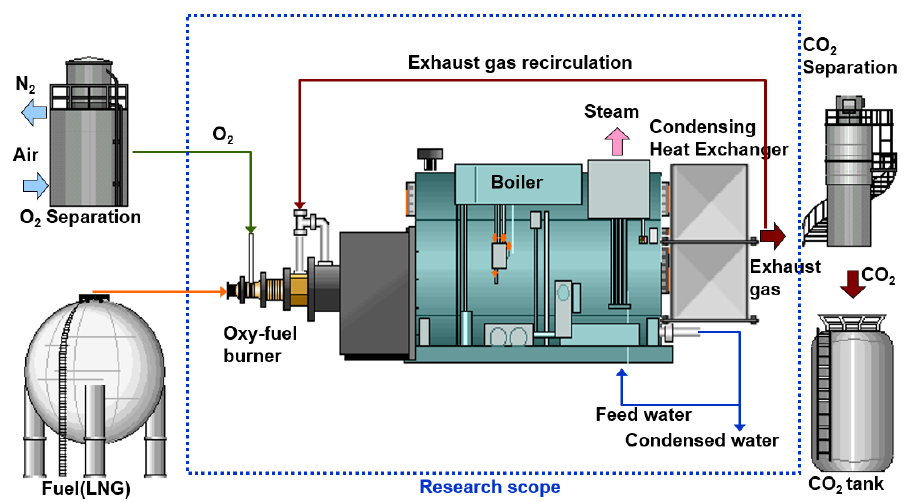
Figure 1. Oxy-fuel flue gas recirculation (FGR) combustion boiler for CO 2 capture.